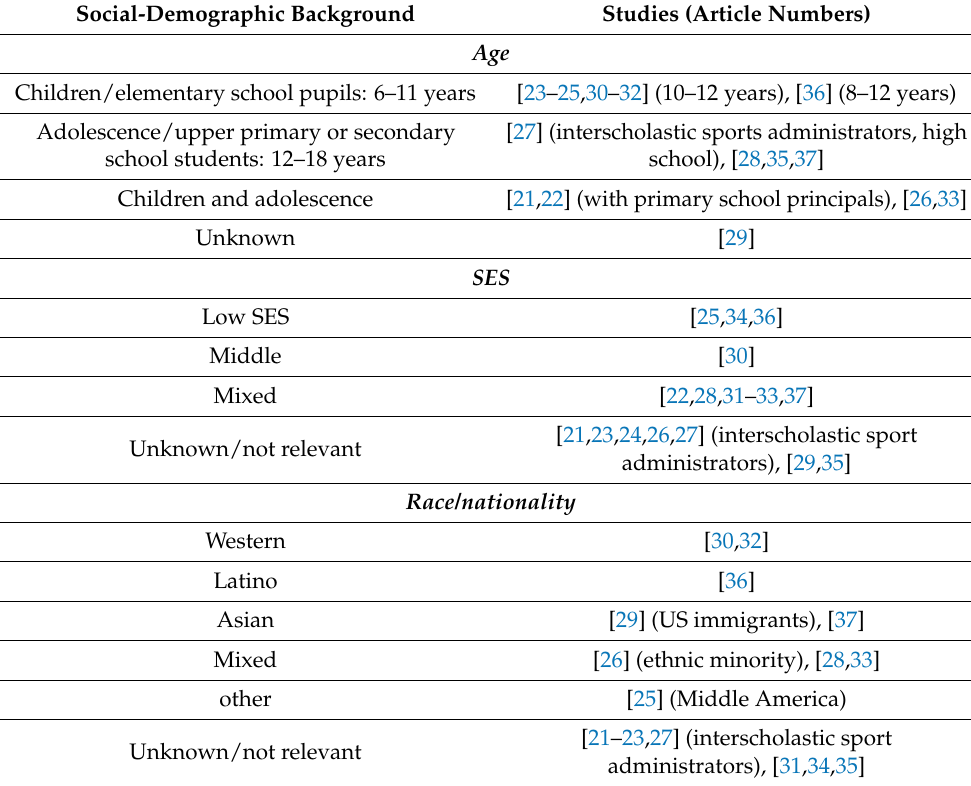
Table 3. Studies categorised according to the social-demographic background